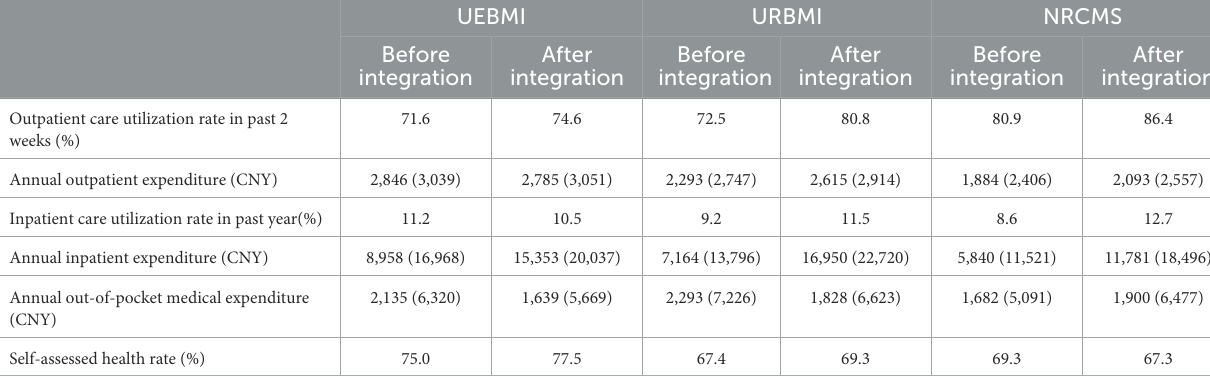
TABLE 3 The average and standard deviation (SD) of dependent variables.